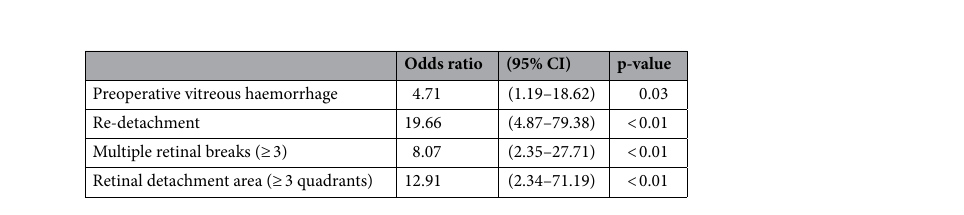
Table 3. Multivariate analysis of risk factors for macular